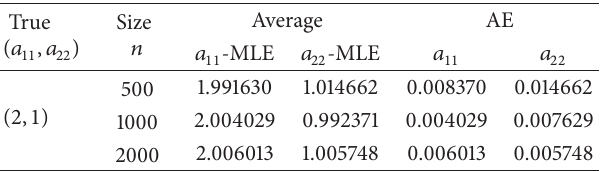
Table 1: The simulation values of the MLE of (𝑎 11 , 𝑎 22 ) when Δ𝑡 = 0.1 .